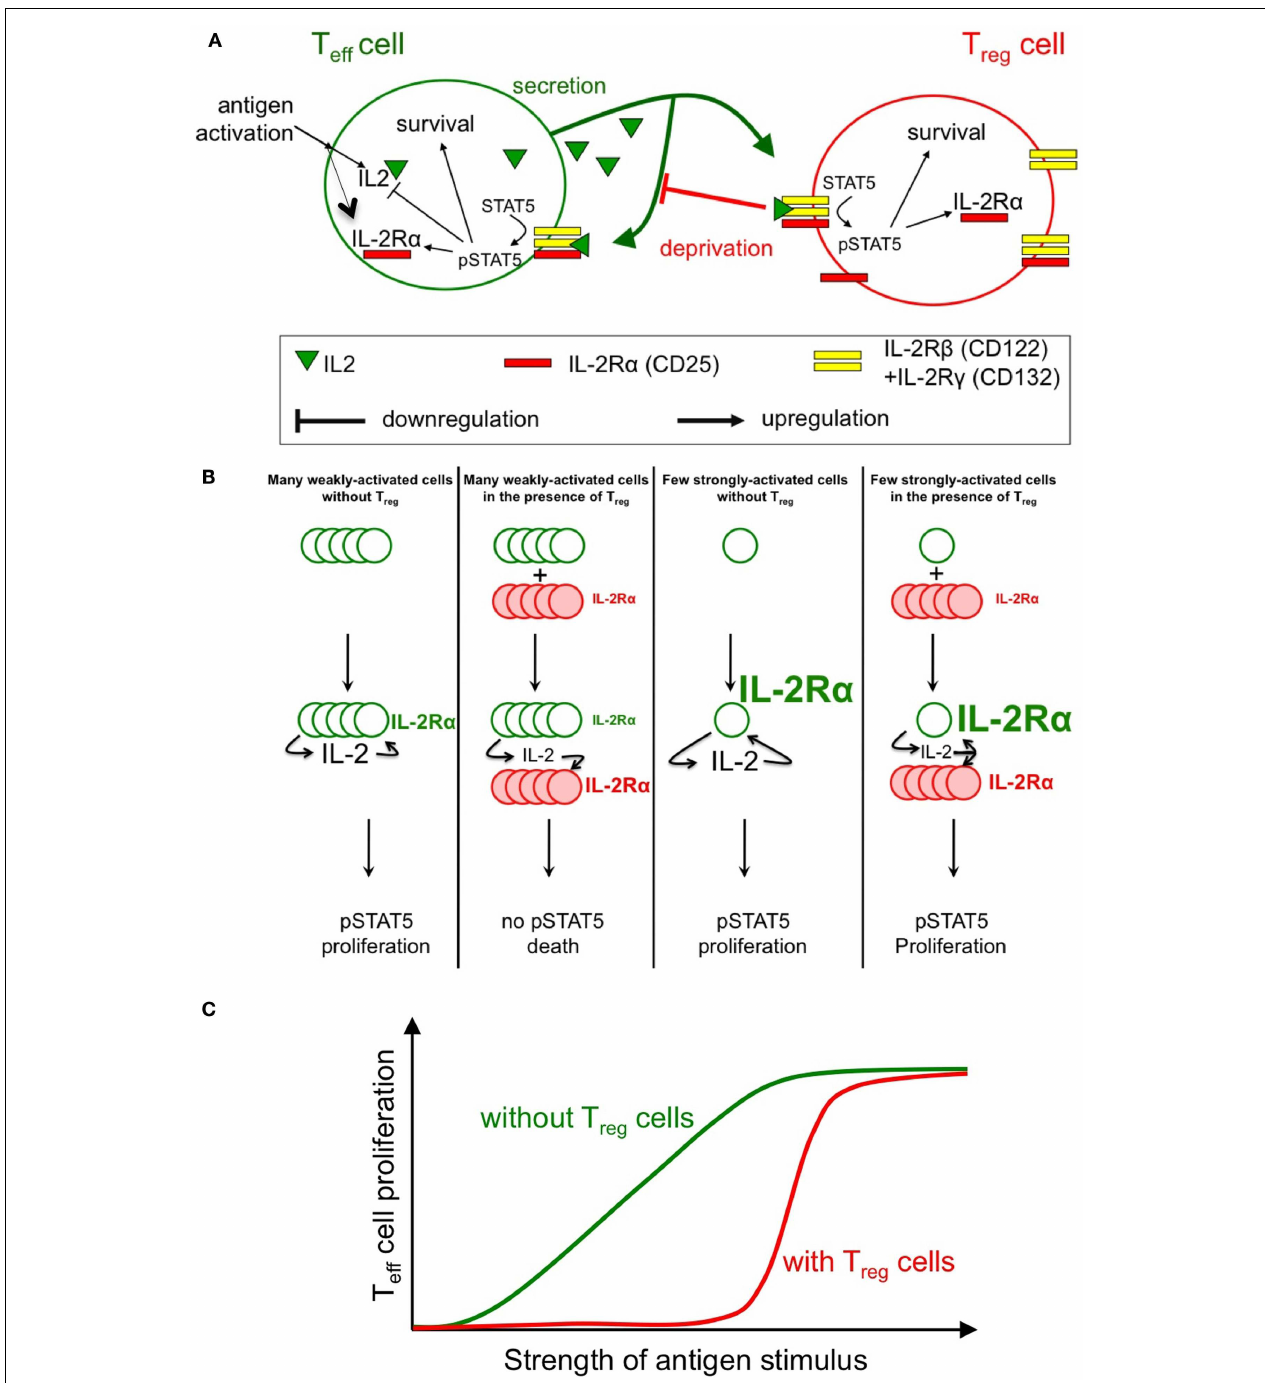
and IL-2 accumulation hence abrogating STAT5 phosphorylation (B) ; (2)This suppression is highly dynamic and variable: in particular,T reg cells can rely on the competition for IL-2 to block the proliferation of weakly activatedT eff cells, while allowing strongly activatedT eff cells to mount an immune response (C) ; note how the presence ofT reg cells reduce the overall proliferation ofT eff cells but, as well, sharpen the dose responsive curve for proliferation vs. antigen strength; (3) Complex spatio-temporal coupling allowT reg cells to modulate and regulate the extent of suppression in crowded environments (e.g., in vivo